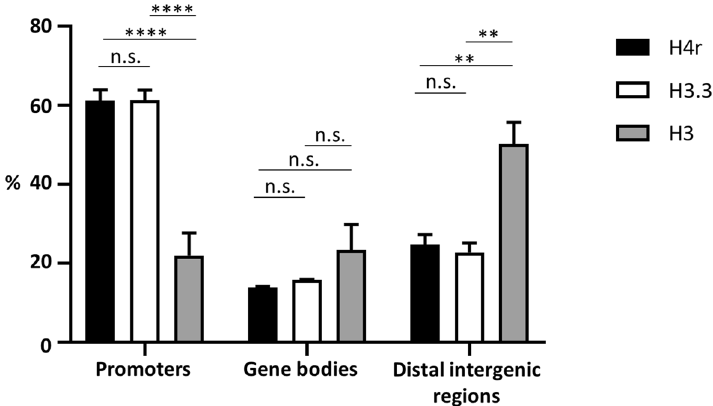
Figure 5. Distribution of H4r, H3.3 and canonical H3 on different genomic regions. Promoters: TSS ± 1 kb; Gene bodies: 5’UTR, exons, introns, 3’UTR, downstream 300 bp; Distal intergenic regions: > 300 bp